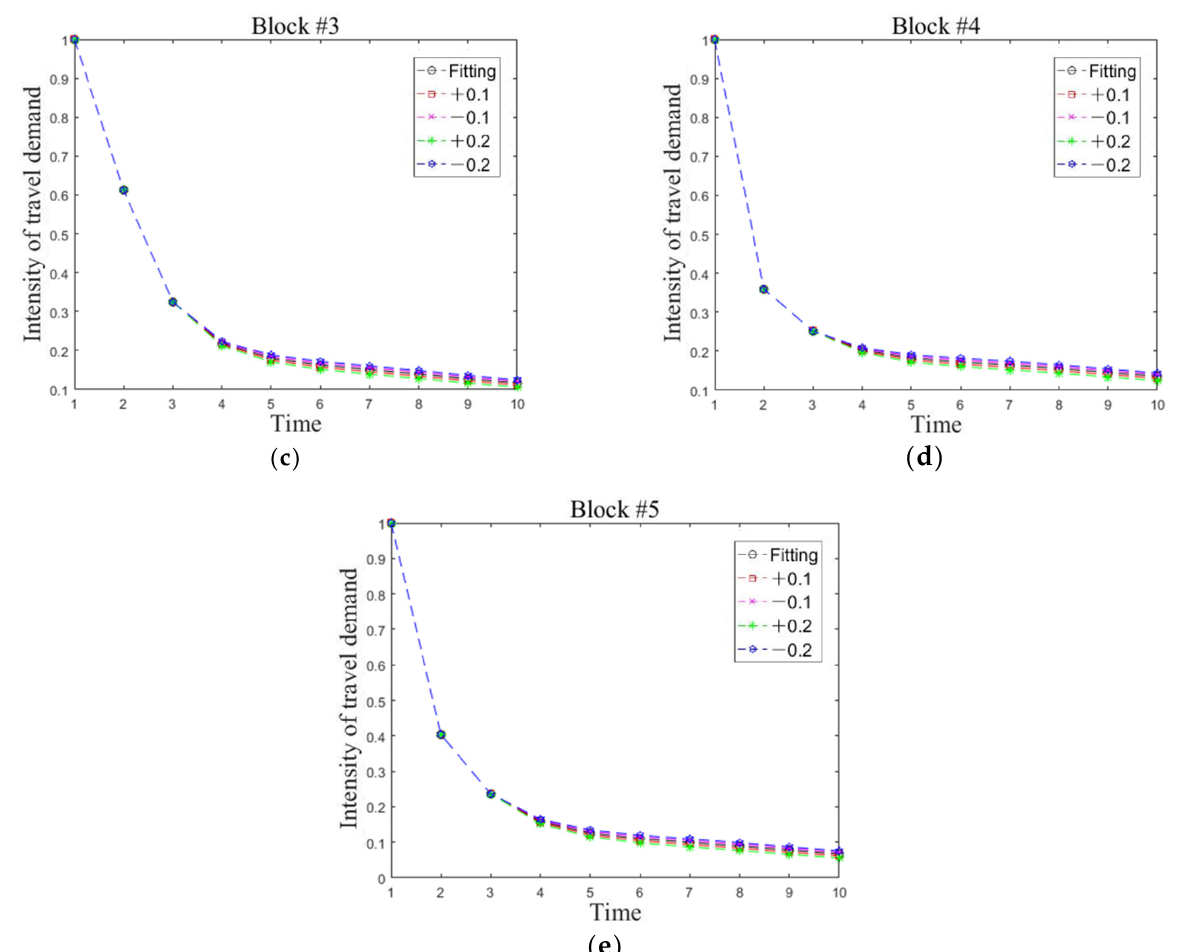
Figure 10. The impact of changes in parameter c 12 on the demands of all blocks. ( a ) Demand sensitivity of block #1. ( b ) Demand sensitivity of block #2. ( c ) Demand sensitivity of block #3. ( d ) Demand sensitivity of block #4. ( e ) Demand sensitivity of block #5.